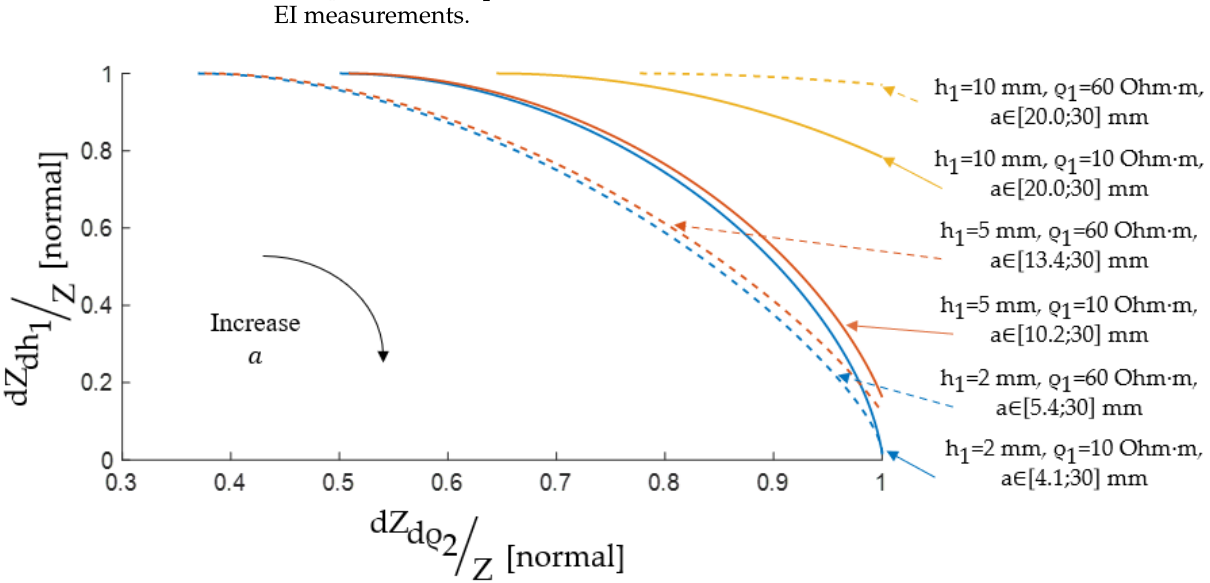
Figure 13. Pareto sets for EI sensitivity criteria.